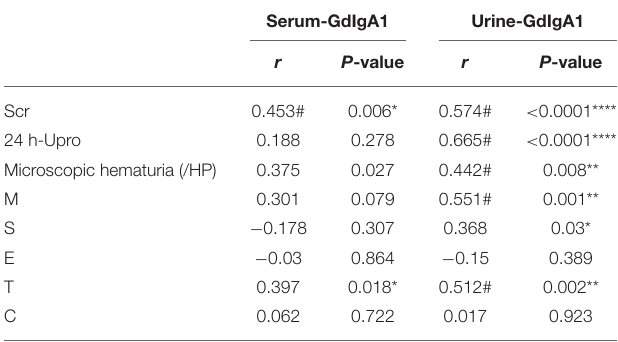
TABLE 2 | Correlation between Gd-IgA1 and clinical indexes. Serum-GdIgA1